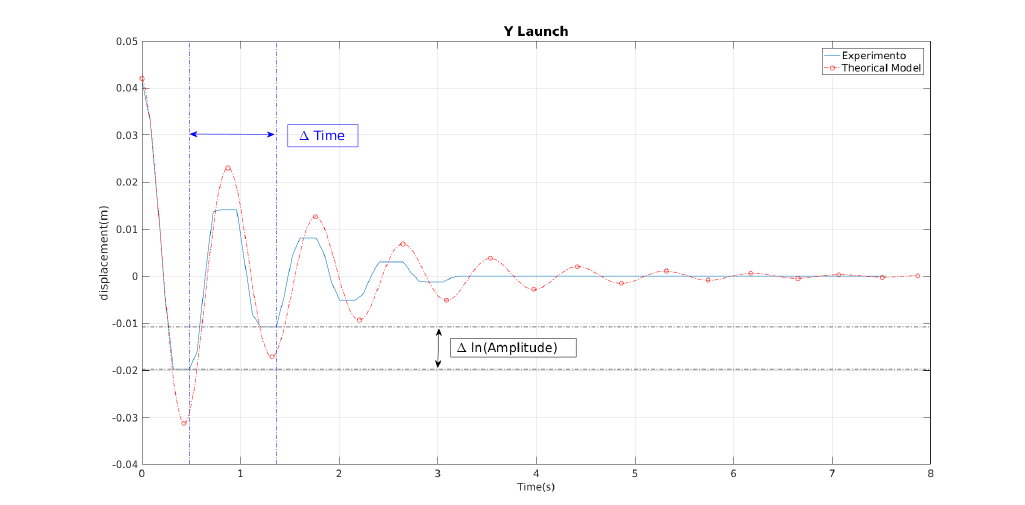
Figure 7. The behaviour of a launch on the Y -axis for 4 cm of amplitude. The value of ∆ (time) is the distance between two consecutive peaks. The value of ∆ (ln(Amplitude)) is the logarithmic variation between the two values. The blue line is the result of the experiment and the red line is the response of the reconstructed model from those values.